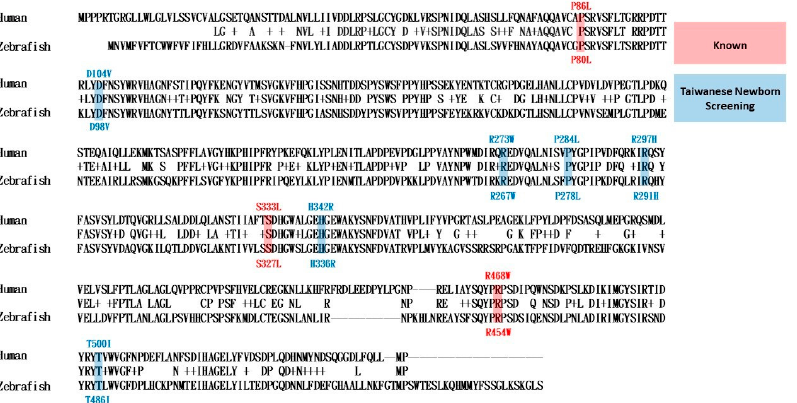
Figure A2. Sequence alignment and conservation between human and zebrafish IDS proteins.